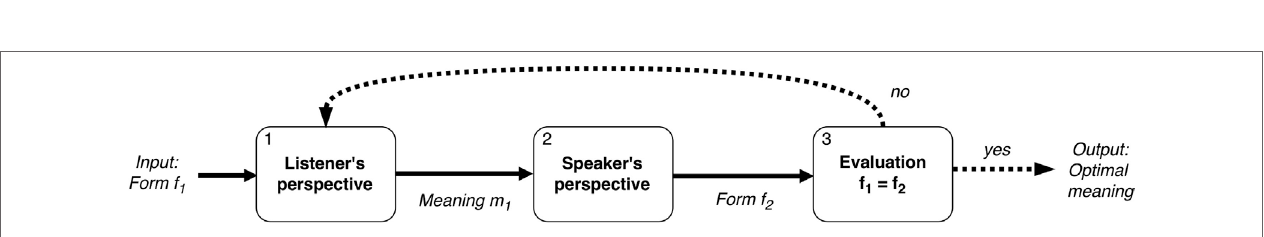
FigURe 6 | The optimization process as implemented in the RR&H model to determine the optimal meaning for a form such as him in Example (4) (in comprehension), and the optimal form for a meaning such as co-reference [(in production), based on Van Rij et al. (2010)].